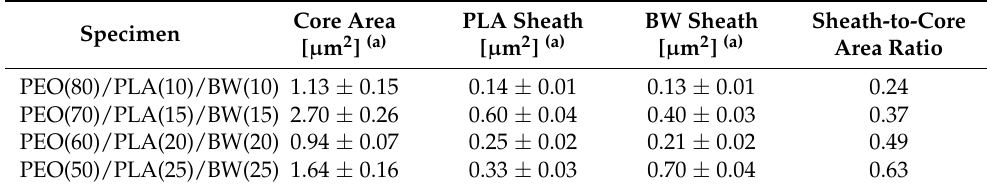
Figure 2. TEM micrographs of a PEO/PLA/BW fiber prepared at weight ratios of PEO(80)/PLA(10)/BW(10) ( a ), PEO(75)/PLA(15)/BW(15) ( b ), PEO(60)/PLA(20)/BW(20) ( c ) and PEO(50)/PLA(25)/BW(25) ( d ). Magnification: ×10,000. Table 1. Area of a segment from a fiber core and sheaths, as well as the sheath-to-core area ratio as estimated using the recorded TEM images.